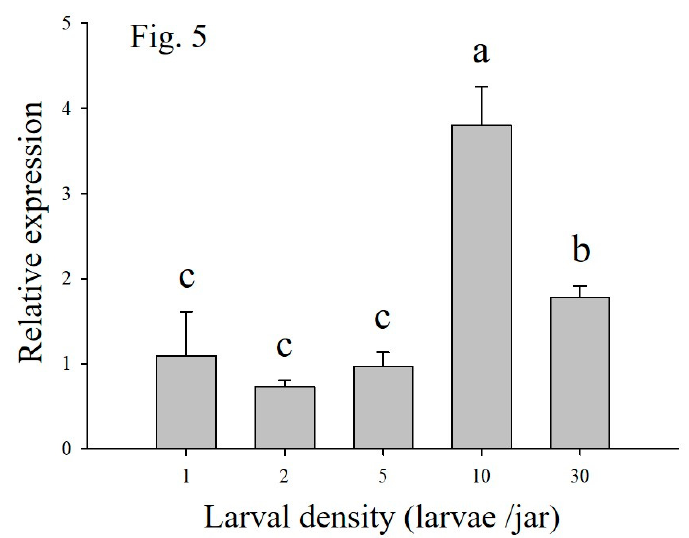
Figure 5. Transcriptional profiles of tyramine β -hydroxylase ( T β h ) of M. separate larvae reared at one, two, five, 10, and 30 larvae per jar. Data are presented as the mean ± SE, n = 3. Different characters denote significant difference at p < 0.05.